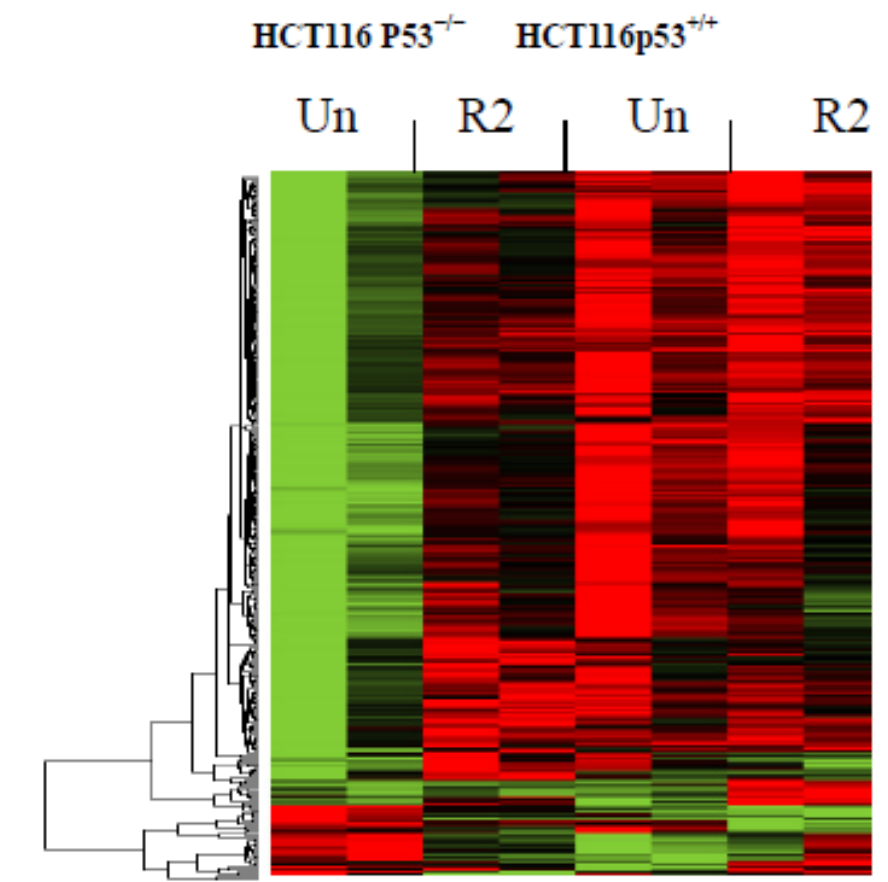
Figure 1. Gene expression profiling in HCT116 p53 +/+ and HCT116 p53 − / − cells in response to R2. The heatmap of untreated and R2-treated cells demonstrated significantly up-and down-regulated ( p < 0.05) genes in colon cancer cells. The heatmap is shown in the left panel. Red indicates significantly up-regulated genes, and green indicates down-regulated genes ( p < 0.05). Un-marks Untreated cells, R2 marks HCT116 cells treated with 25 μ M R2 for 24